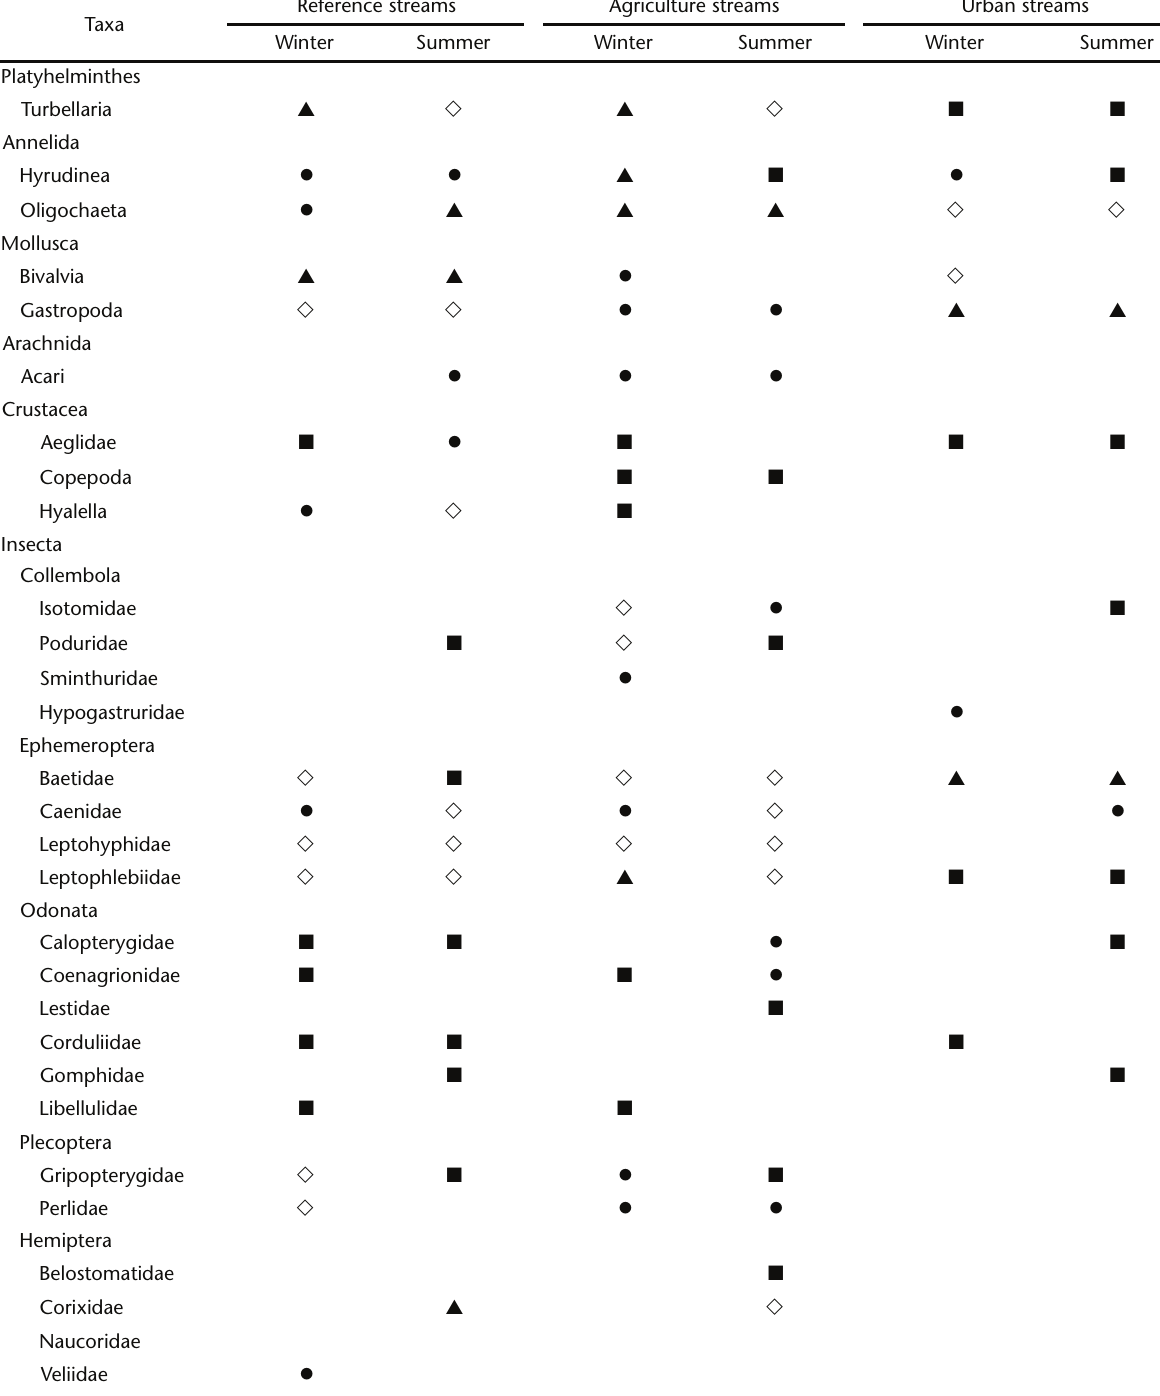
Table III. Values of organisms density in streams with different land uses influence in Erechim, Rio Grande do Sul state. ( (cid:2) ) < 10, ( (cid:2) ) 11-50, ( (cid:2) ) 51-100, ( (cid:3) ) > 100. Reference streams Agriculture streams Urban streams Taxa